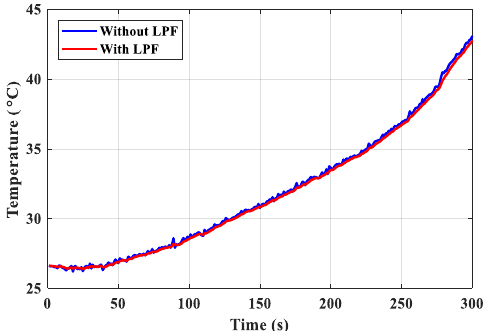
Figure 8. Noise is suppressed by the first-order low-pass filter.